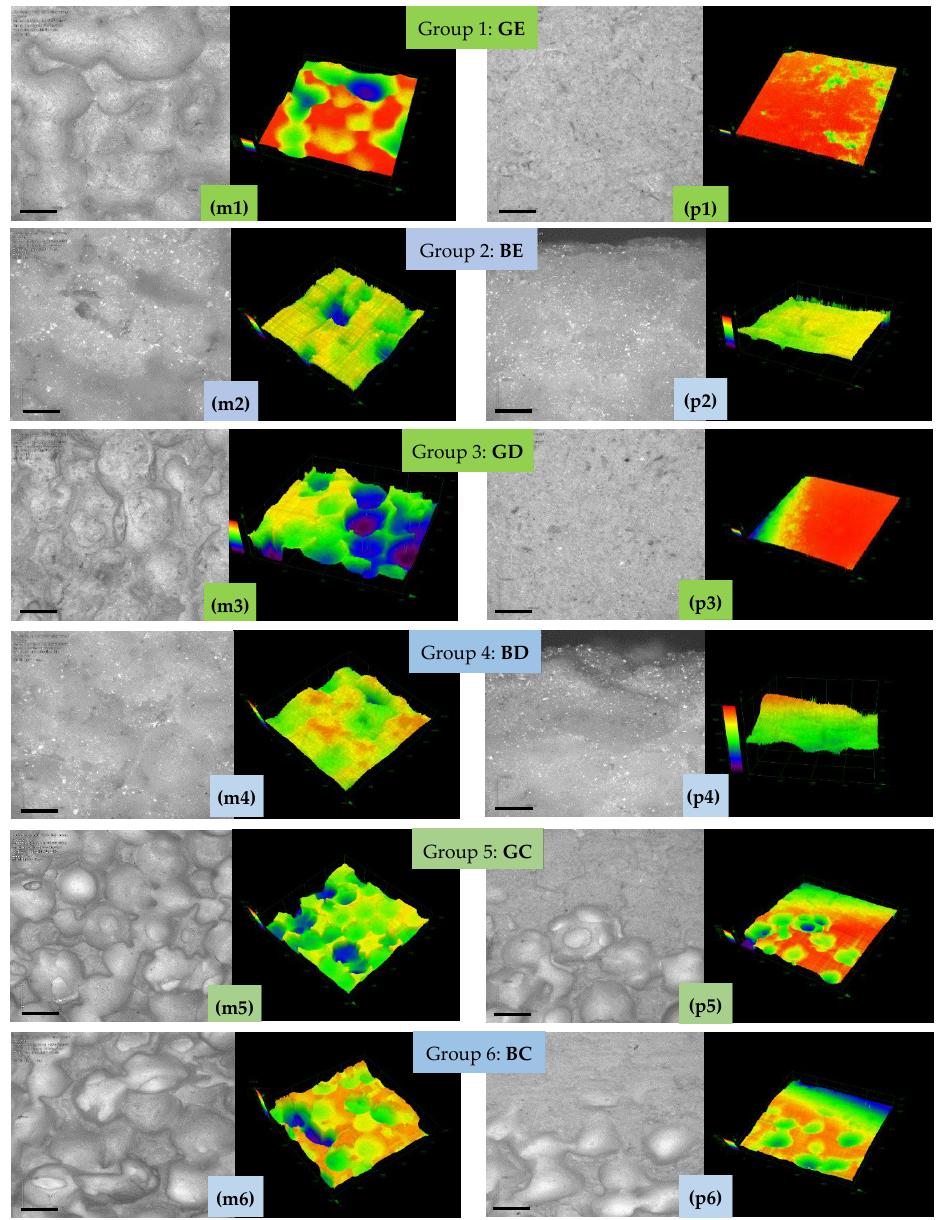
Figure 8. ( m1 – m6 ) Median and ( p1 – p6 ) peripheral/bottom positions for samples from Group 1 ( GE ), Group 2 ( BE ), Group 3 ( GD ), Group 4 ( BD ), Group 5 ( GC ), and Group 6 ( BC ). For each group and considered position, the left image is the microscopic (frontal) one and the right image is the 3D surface reconstruction. Scale: 500 μm. In all cases (i.e., for all six groups), using both imaging methods, there was a clear distinction between the cortical (p) and the internal (m) structure. The former generated